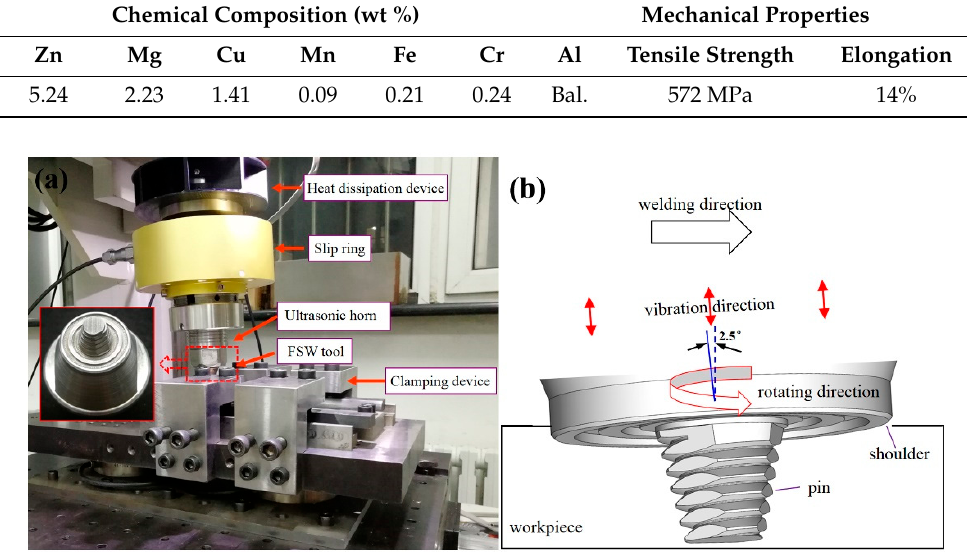
Figure 1. ( a ) Experimental apparatus and ( b ) schematic apparatus for axial ultrasonic-vibration-assisted friction stir lap welding (FSLW).